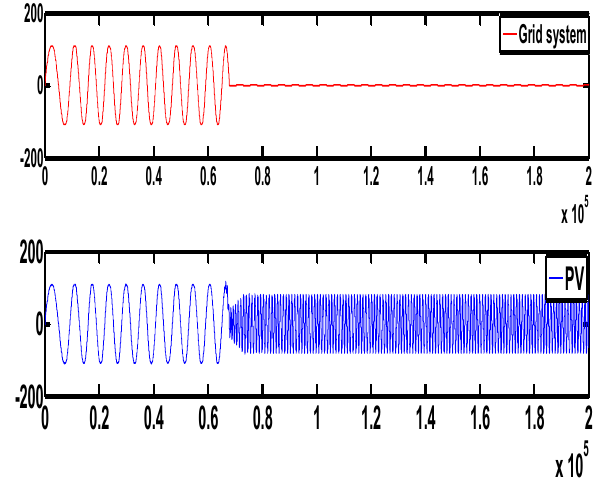
Figure 11. Monitored waveforms of detected signals. Table 1. Extension element model showing when islanding will occur.